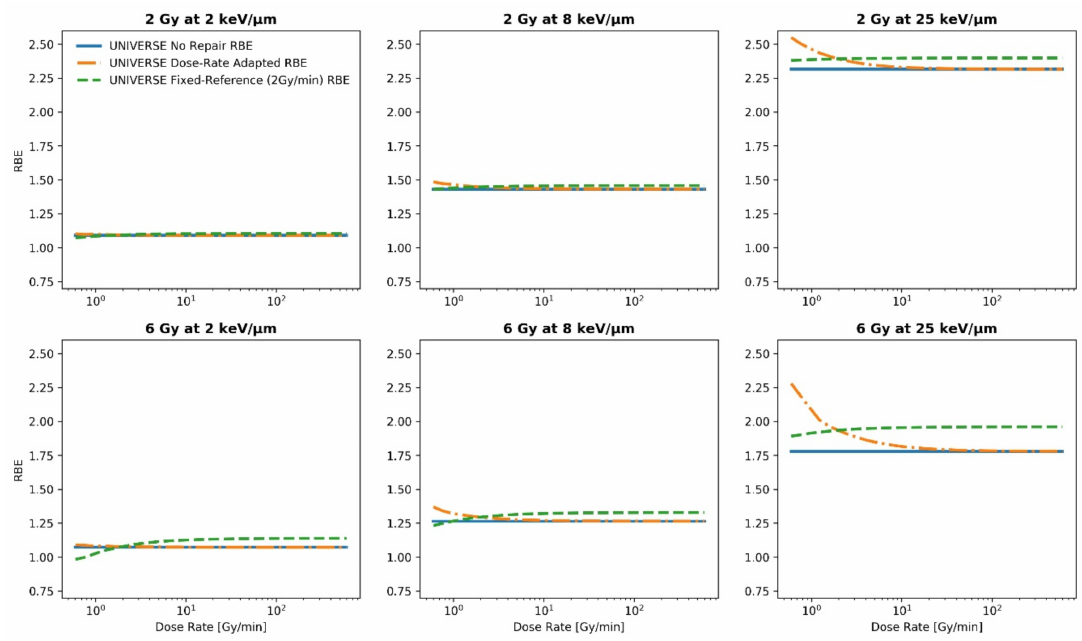
Figure 1. Proton RBE predictions for the DU145 cell-line over the applied dose rate for the fixed- reference RBE (2 Gy/min; green dashed line) as well as the dose-rate adapted RBE (dotted orange line) by using the extended version of the UNIVERSE for three representative LET values at moderate doses. The no-repair RBE is shown for reference (solid blue